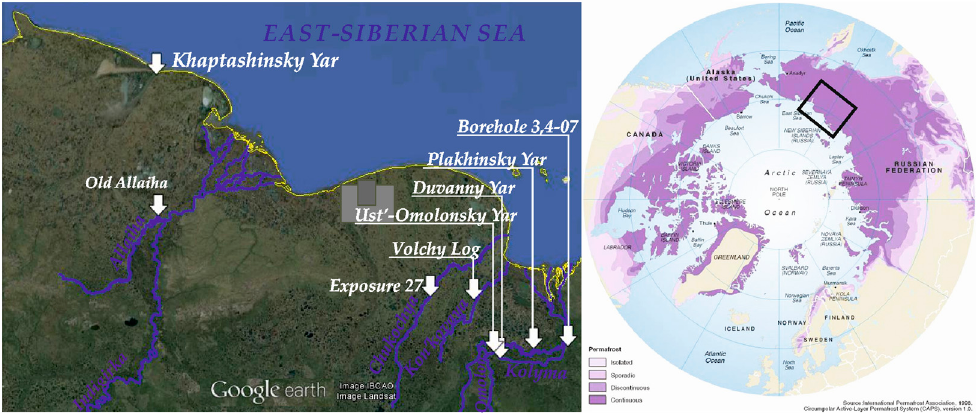
Figure 1. Location of the methane sampling sites in the northeastern Siberia; the area squared on the Circum-Arctic permafrost map [29]. Reproduced with permission from Philippe Rekacewicz, visionscarto.net.